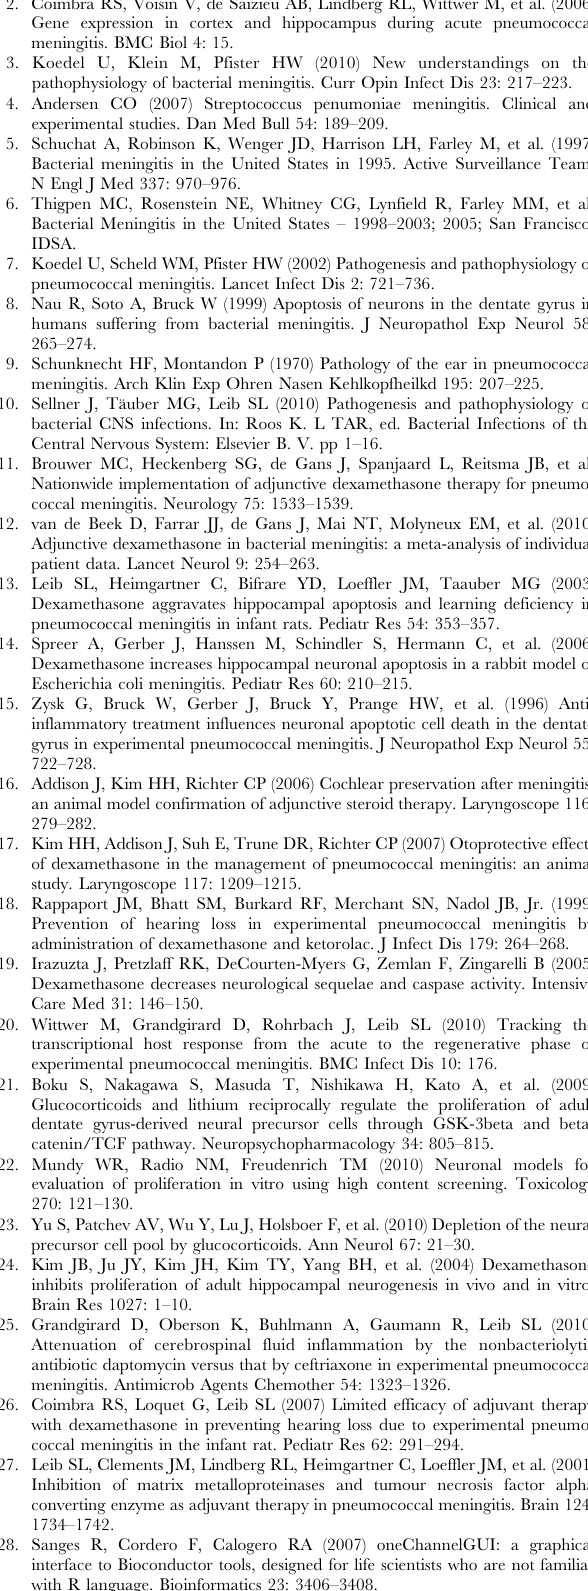
table of contents. 46. Grandgirard D, Bifrare YD, Pleasure SJ, Kummer J, Leib SL, et al. (2007) Pneumococcal meningitis induces apoptosis in recently postmitotic immature neurons in the dentate gyrus of neonatal rats. Dev Neurosci 29: 134–142. 47. Hofer S, Grandgirard D, Trachsel T, Leib SL Apoptosis of neurogenic cells in an in vitro model of bacterial meningitis; 2010; Vienna (Austria). 48. Barnes PJ (2010) Mechanisms and resistance in glucocorticoid control of inflammation. J Steroid Biochem Mol Biol 120: 76–85. 49. Zhang Z, Artelt M, Burnet M, Schluesener HJ (2007) Dexamethasone attenuates early expression of three molecules associated with microglia/macrophages activation following rat traumatic brain injury. Acta Neuropathol 113: 675–682.